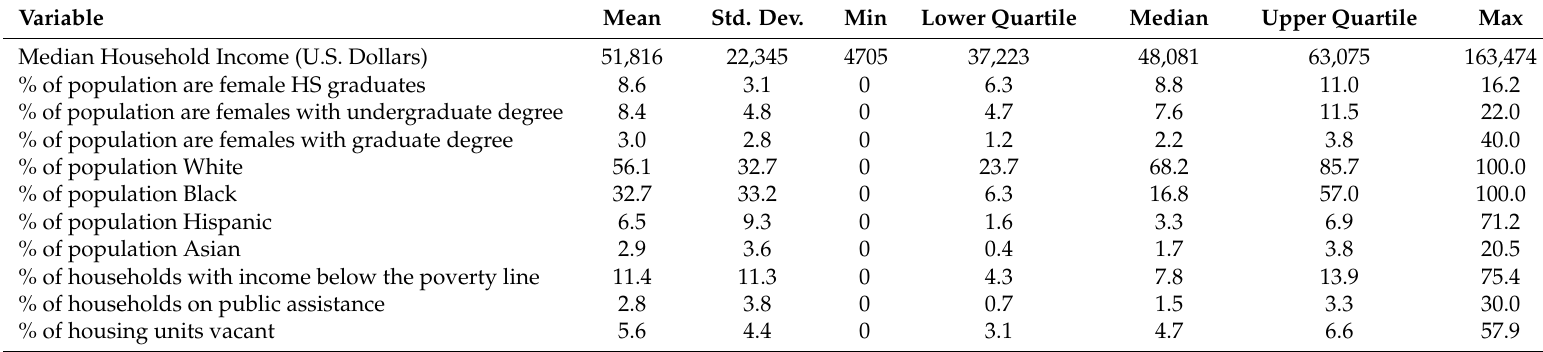
Table 2. Socio-demographic characteristics of all census tracts within the 20 county Atlanta MSA ( N =